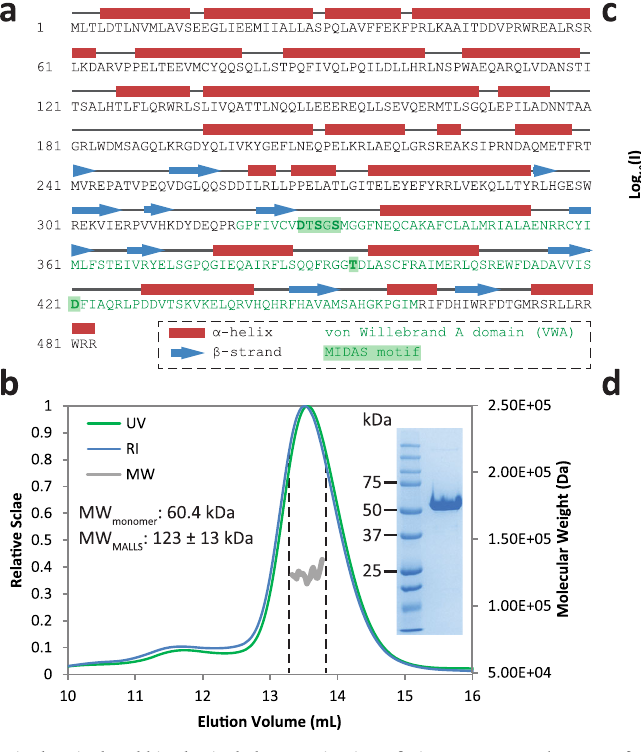
Fig. 1 | Biochemical and biophysical characterization of ViaA. a Annotated sequenceof E.coli ViaA,withpredicted α -helicesshownasredtubesandpredicted β -strands shown as blue arrows. The von Willebrand A (VWA) domain of ViaA is shownin green,with the MIDASmotifhighlightedindark green. b Molecular mass determination of AviTag-ViaA-His by SEC-MALLS. The differential refractive index (RI) signal is plotted (left axis, blue curve) along with the UV signal (UV, left axis, greencurve)andthedeterminedmolecularweight(MW,rightaxis,greycurve).An SDS-PAGEgelofpuri fi edAviTag-ViaA-Hisisshownasaninsetontheright-handside